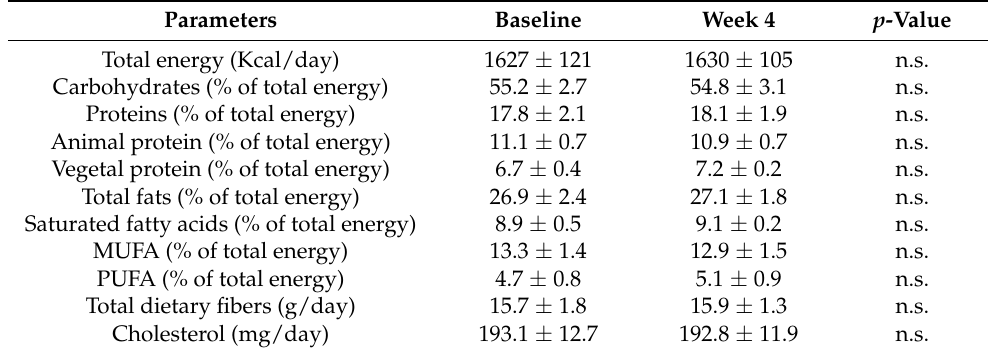
Table 2. Diet composition (g/day) at enrollment and at the end of the intervention. Values are re- ported as mean ± SD.